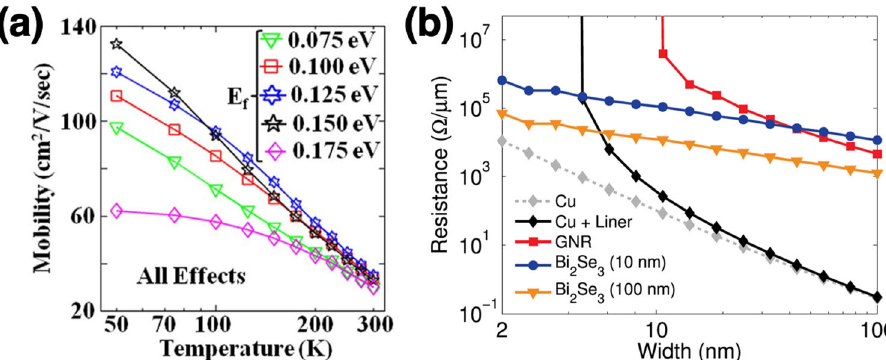
Fig. 4 Topological interconnects. a Numerically calculated mobility of electrons in Bi 2 Se 3 nanowire interconnects when considering non-ideal effects, such as roughness scattering and phonons, as a function of the simulation temperature for various Fermi levels 59 . Reprinted by permission from ref. 59 , copyright 2014. b Theoretical resistance, normalized by the length, of different interconnect technologies compared to that of Bi 2 Se 3 nanowire interconnects as calculated for two different mean-free paths of 10 nm (blue) and 100 nm (orange) 60